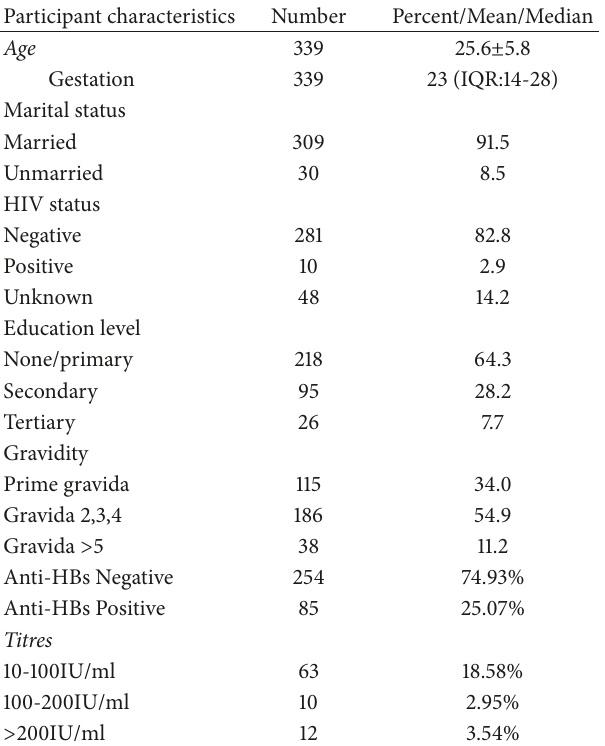
Table 1: Sociodemographic and clinical characteristics of 339 pregnant women attending Makongoro antenatal